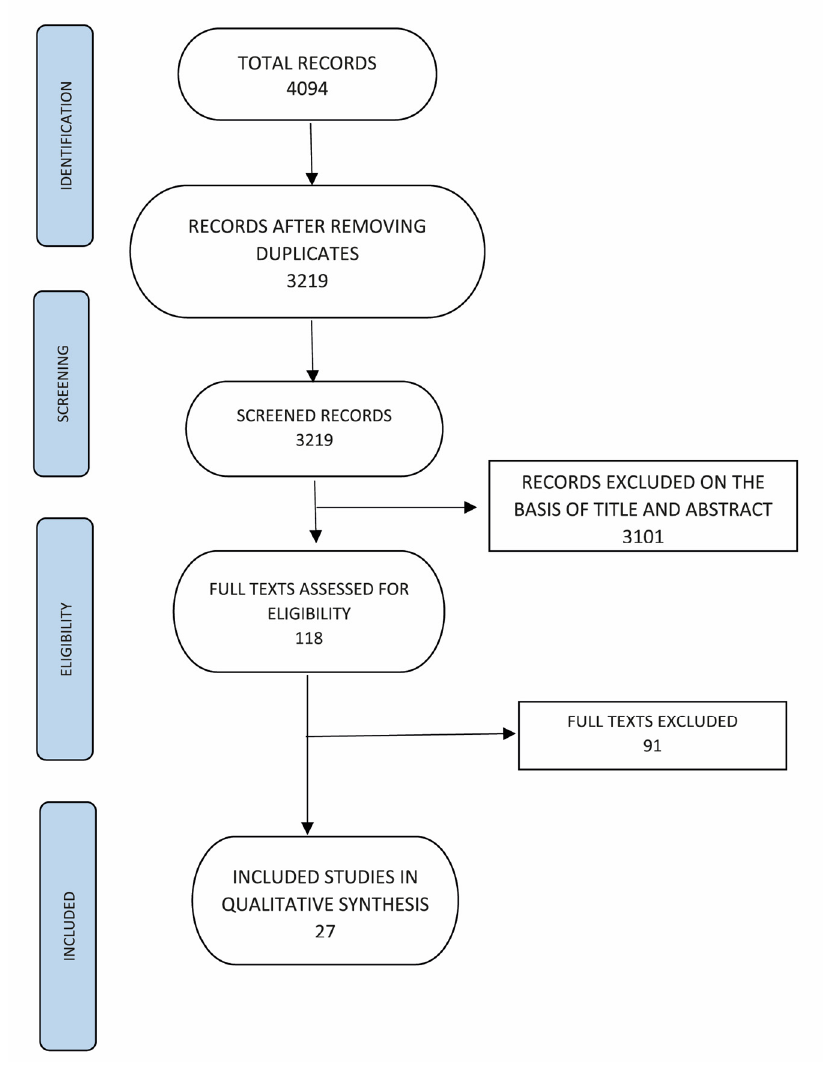
Figure 3. Prisma flow chart of included studies.